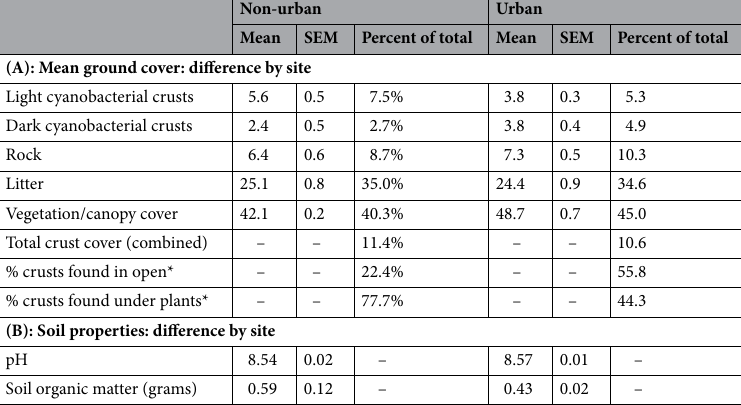
Table 1. (A) Mean ground cover (%) at urban and non-urban sites in and around Tucson, AZ per transect. An asterisk (*) indicates a significant difference found between sites. Statistics were done using a single factor ANOVA test. (B) Soil properties at urban and non-urban sites. Statistics were done using a single factor ANOVA test and no significant differences were found.